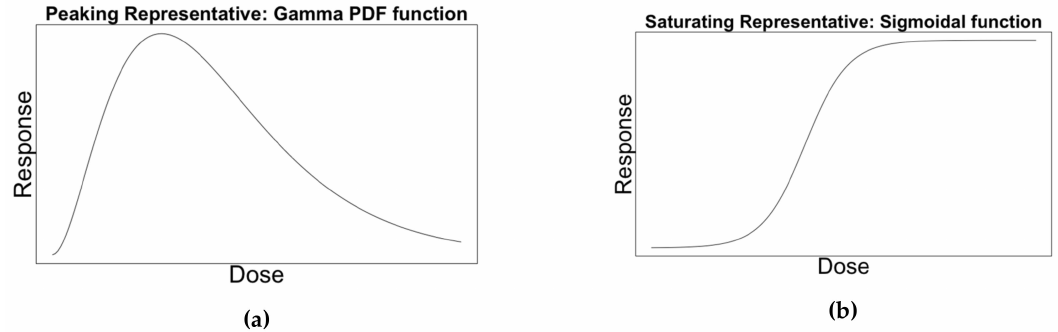
Figure 1. Examples of a representative curve for ( a ) peaking and ( b ) saturating